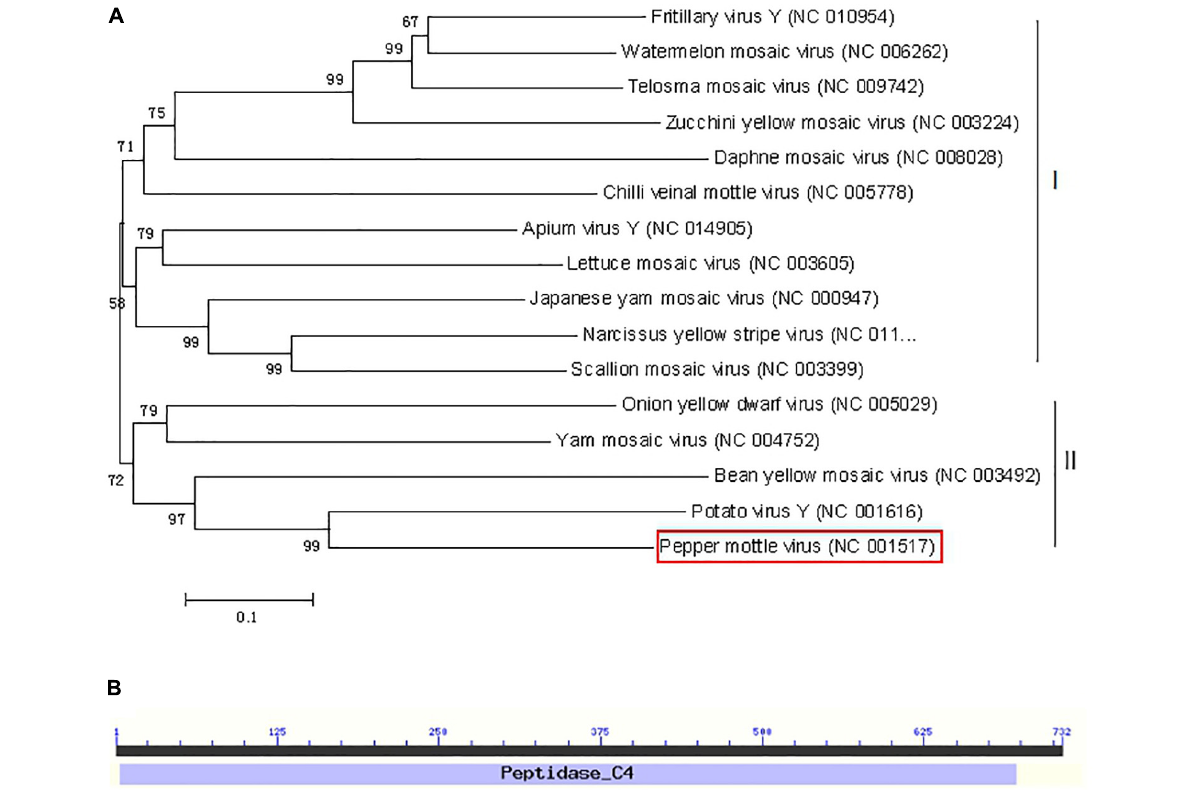
FIGURE 1 | Phylogenetic relationships and domain structure of NIa-Pro nucleotide (nt) sequences of representative potyviruses ( NIa-Pro gene of Pepper mottle virus shown in red box. (A) The nucleotide sequences of the NIa-pro gene from 16 potyvirus viruses were aligned using the neighbor-joining method with the MEGA6 program with 1,000 replications. The numbers beside each node represent the percentages for the bootstrap value ( > 50%). (B) One conserved peptidase domain was identified using the Conserved Domain Database